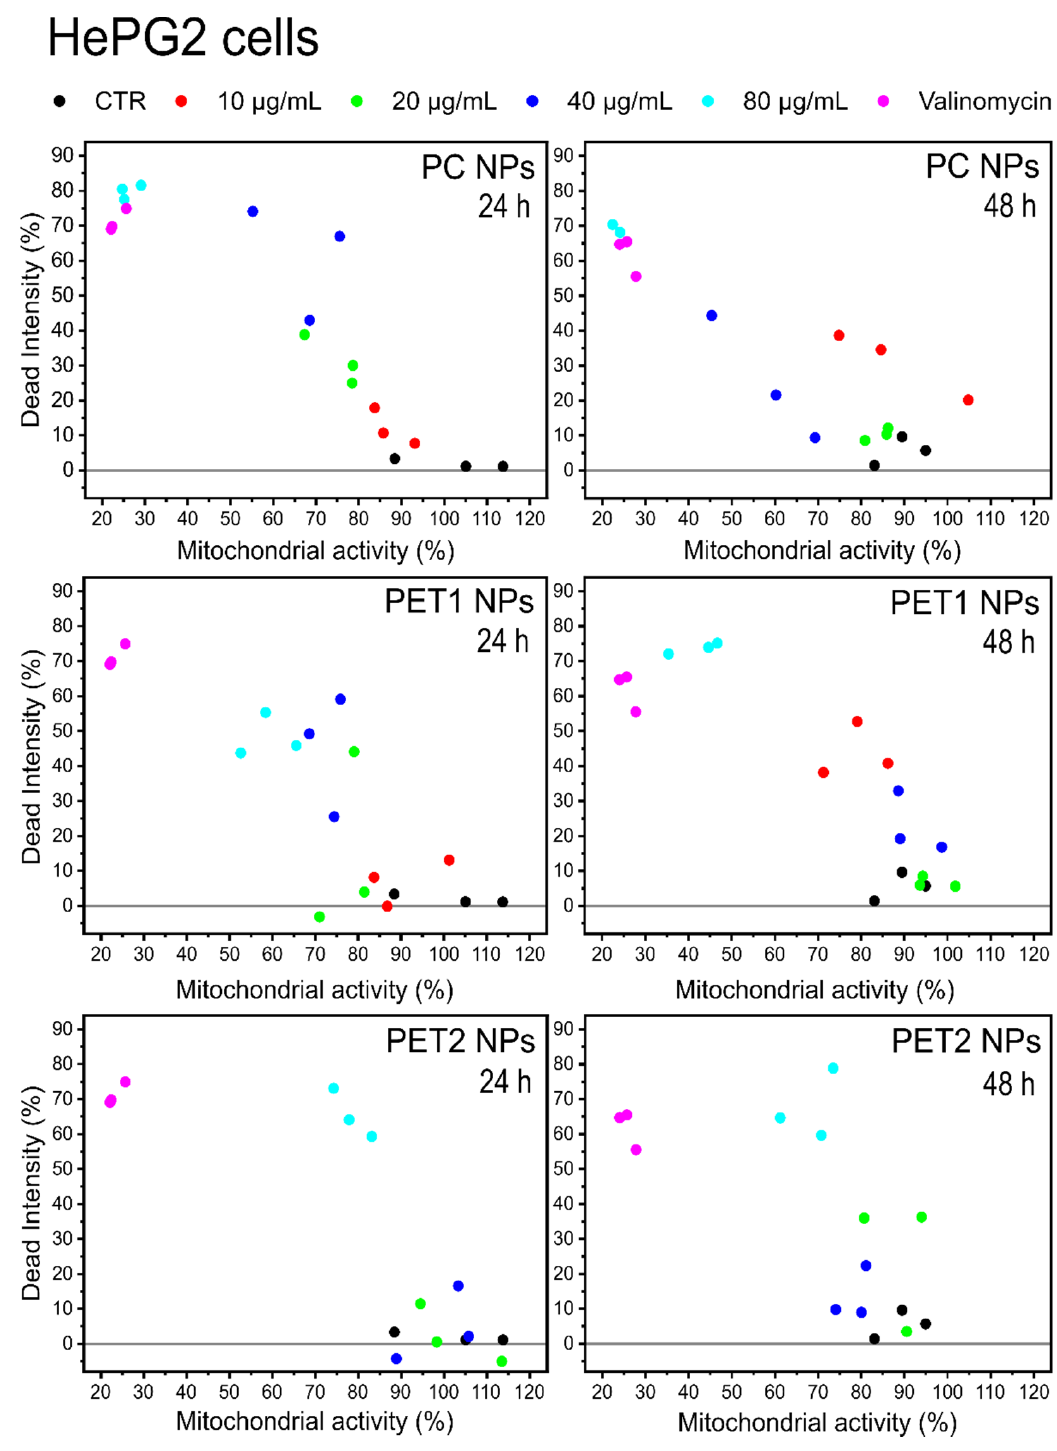
Figure 6. Two-way analysis of HePG2 cells exposed to PC, PET1 or PET2 NPs at concentrations ranging between 10 and 80 µg/mL for 24 or 48 h. Valinomycin was used as positive control. Results are expressed as a function of two different parameters: mitochondrial activity and cellular membrane damage. Data are reported as the average of three independent experiments (each run in triplicate).